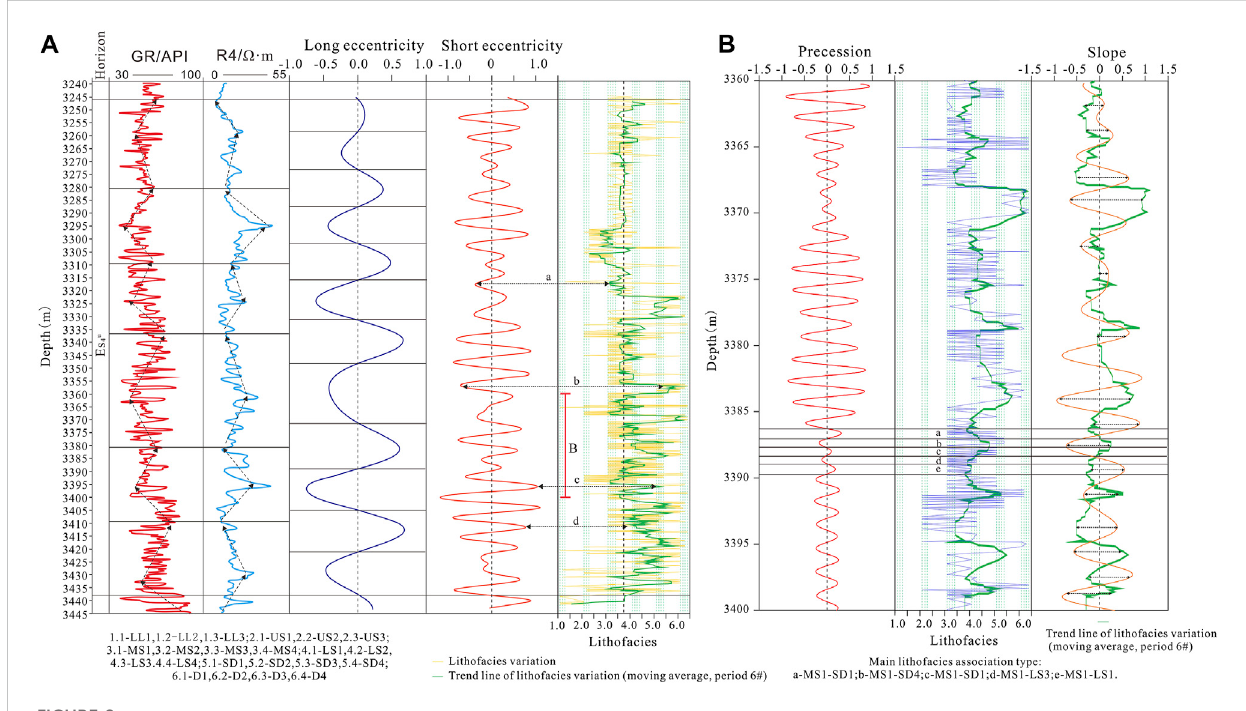
FIGURE 8 Relationship between long eccentricity, short eccentricity and lithofacies (A) and relationship between slope, precession and lithofacies (B)